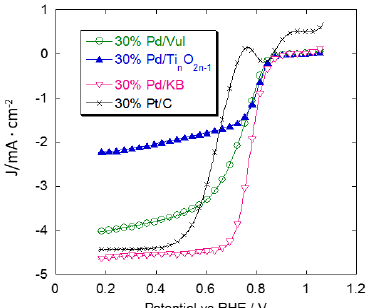
Figure 5. Comparison of oxygen reduction curves for the different Pd/support catalysts and the commercial Pt/C E-TEK catalyst in the presence of 0.1 M MeOH. Scan rate 5 mV·s − 1 ; 1000 rpm; room temperature and 50 μ g·cm − 2 of Pd or Pt loading.